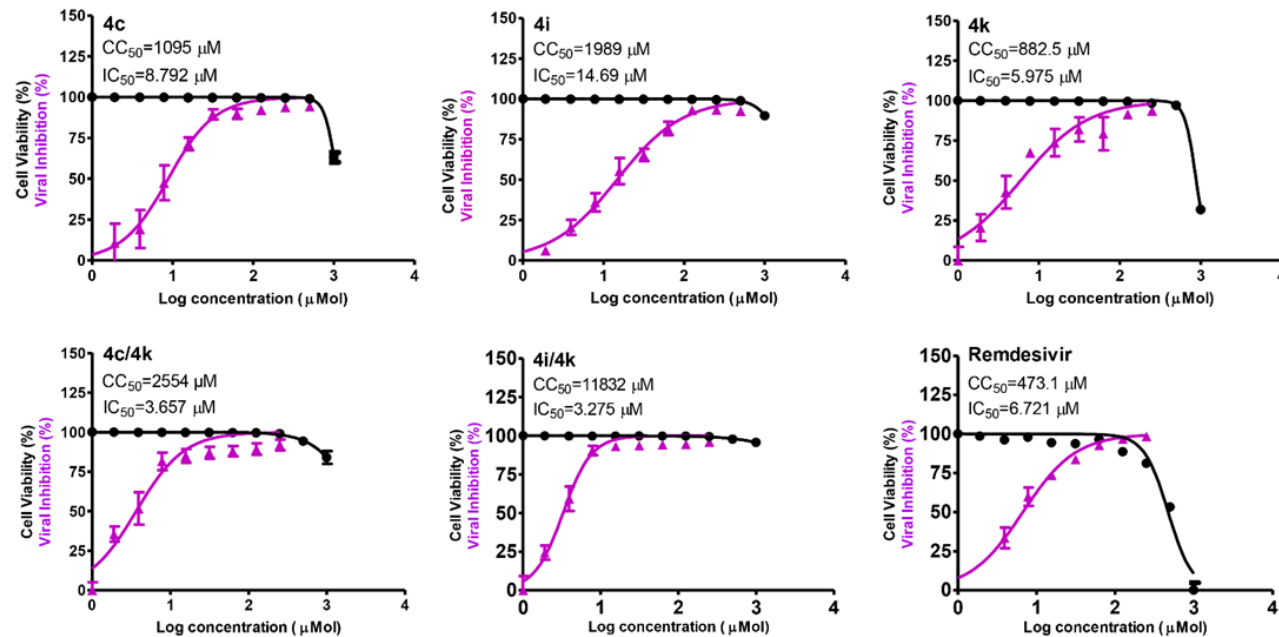
Figure 2. Half maximal cytotoxic concentration (CC 50 ) in Vero-E6 cells and half maximal inhibitory concentration (IC 50 ) of the tested compounds 4c, 4i, and 4k , individually and in combination, against NRC-03-nhCoV in Vero-E6 cells, compared with remdesivir as a drug control. The 50% inhibitory concentration (IC 50 ) of each tested compound was calculated using nonlinear regression analysis in triplicate for each concentration used. The best fitting line was drawn between log concentrations and viral inhibition % using Graph Pad Prism